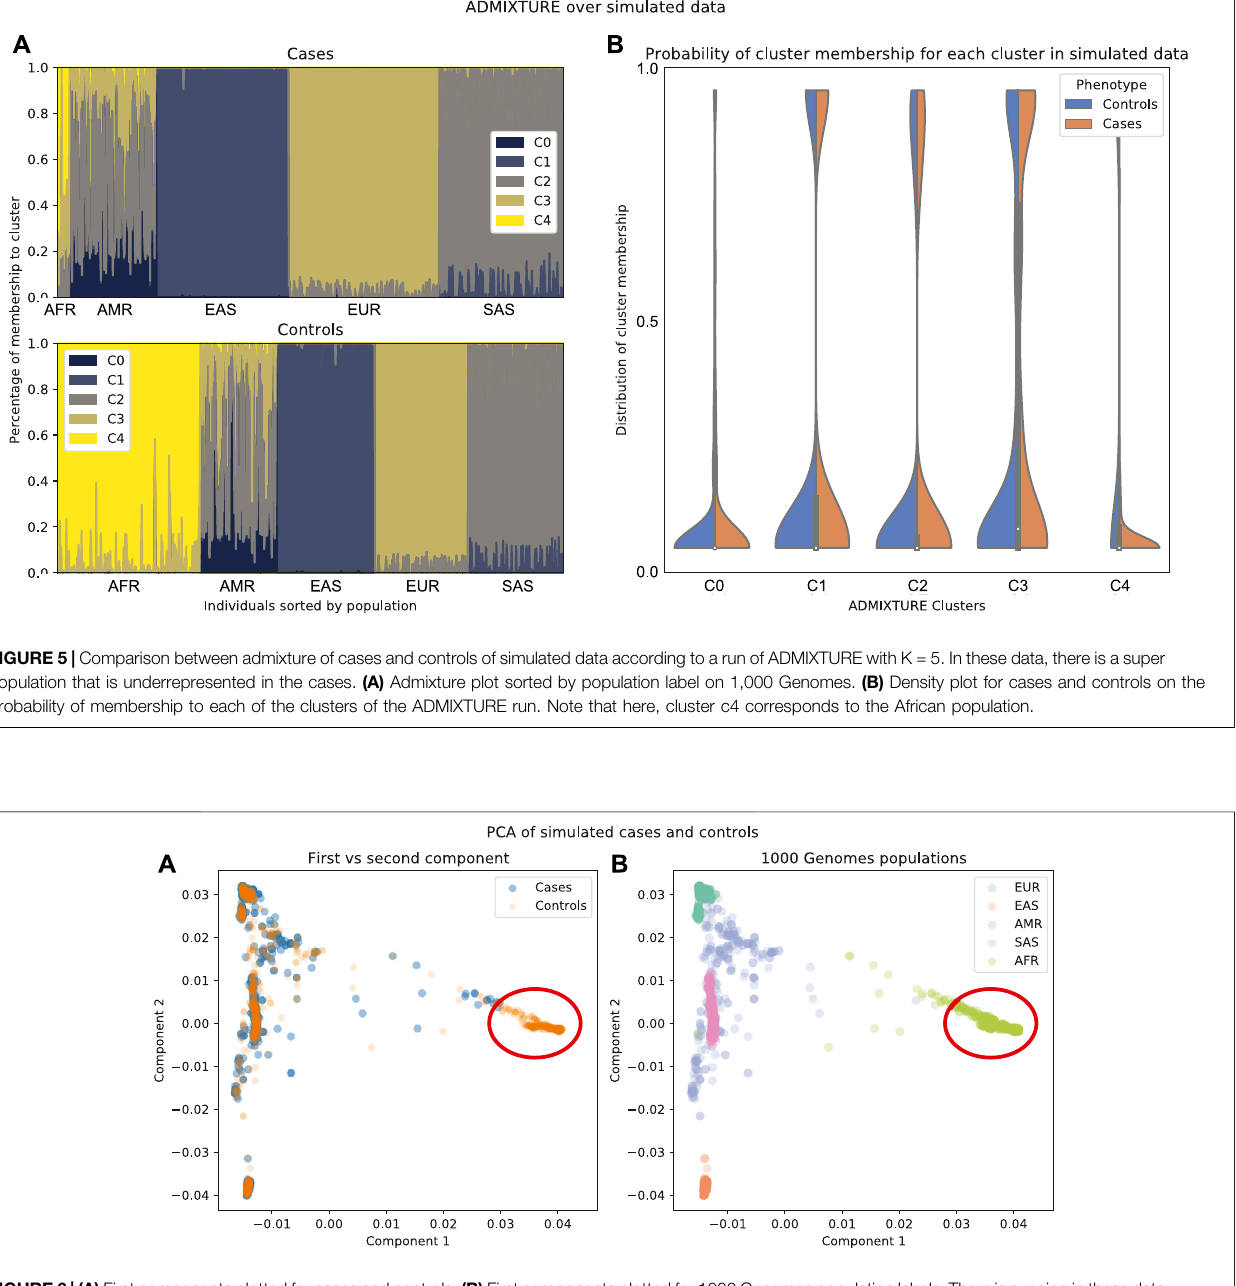
Frontiers in Genetics |